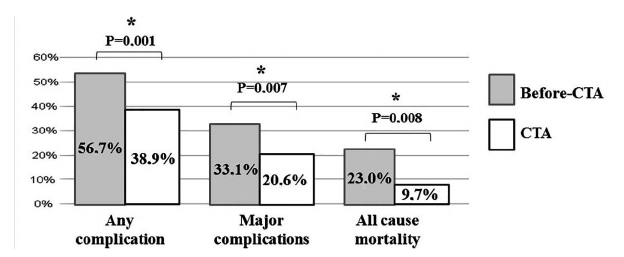
Fig. 1 - Complications and mortality in groups Before-CTA and CTA.